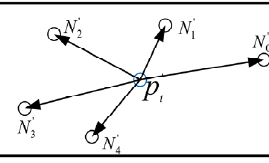
Figure 4. Points projection.